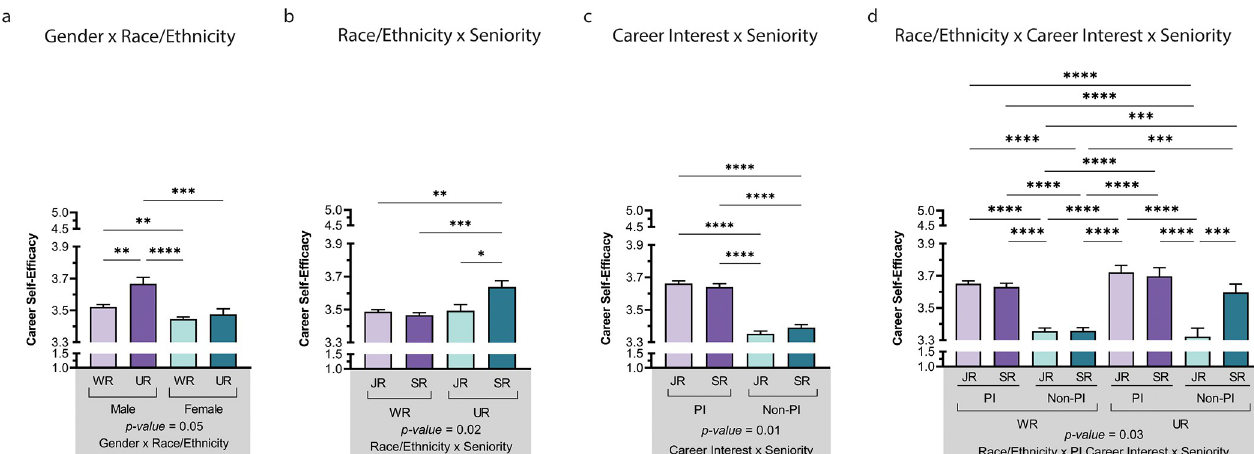
Fig 2. Interactions of gender, race/ethnicity, career interest, and seniority. Legend. Patterns for gender and race/ethnicity were generally similar to the primary analysis; however, they also showed interactions with career interest and seniority. Career interest showed a significant main effect, with higher CSE for those strongly interested in becoming a PI at a research-intensive institution compared to those with moderate -to-no interest in this career path. The effects of seniority trended slightly higher for junior trainees than senior trainees, but differences were more pronounced in the career interest x seniority interaction, which attained significance. Post-hoc t-tests were conducted between all possible pairings as illustrated by each end of the respective bracket. P-values indicate significance of Tukey’s multiple comparison tests (see S5 File for full table of values), ���� p < 0.0001, ��� p < 0.001, �� p < 0.01, and � p < 0.05. Significance values at the bottom of each panel (a-d) indicate interactions. Panel 2d displays the 3-way ANOVA with only multiple comparisons not represented in other panels included (e.g., not displayed in panels 2a-c). Note : WR = Well-Represented, UR = Underrepresented, JR = Junior, SR = Senior. Color differences (green and purple) indicate the primary variables. For 2a gender (male vs. female), 2b race/ethnicity (WR vs. UR), 2c career interest (PI vs. non-PI), and 1d race/ethnicity (WR vs. UR) and career